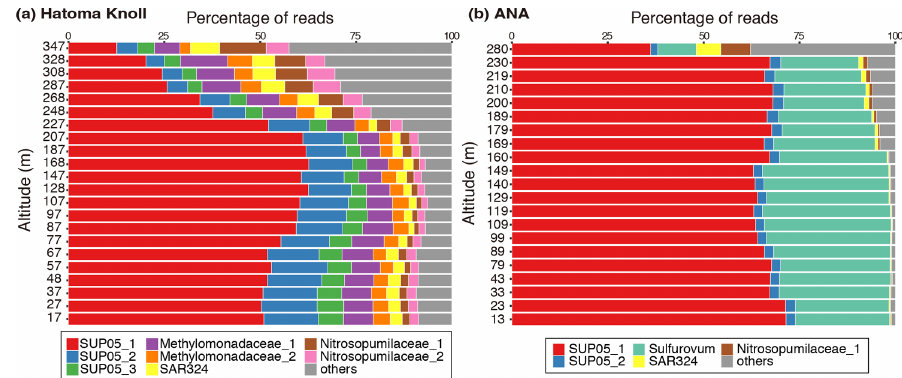
Figure 5. Prokaryotic composition of (a) Hatoma Knoll plume and (b) ANA plume. The top 10% (49 ASVs) of 4880 ASVs, in terms of total read abundance in this study, were defined as the major group. Read abundance of the major group corresponds to 83% of the total read abundance of the samples. The names and colors in the legend are identical in these two panels.